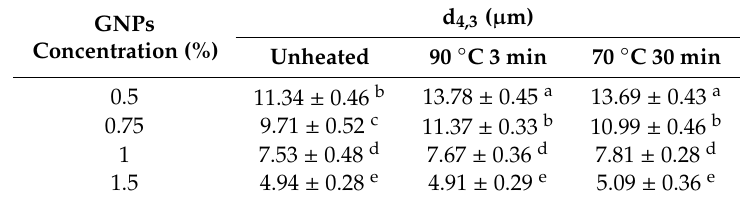
Table 2. Mean diameter of β -carotene varied with GNPs concentration (mean ± SD, n =